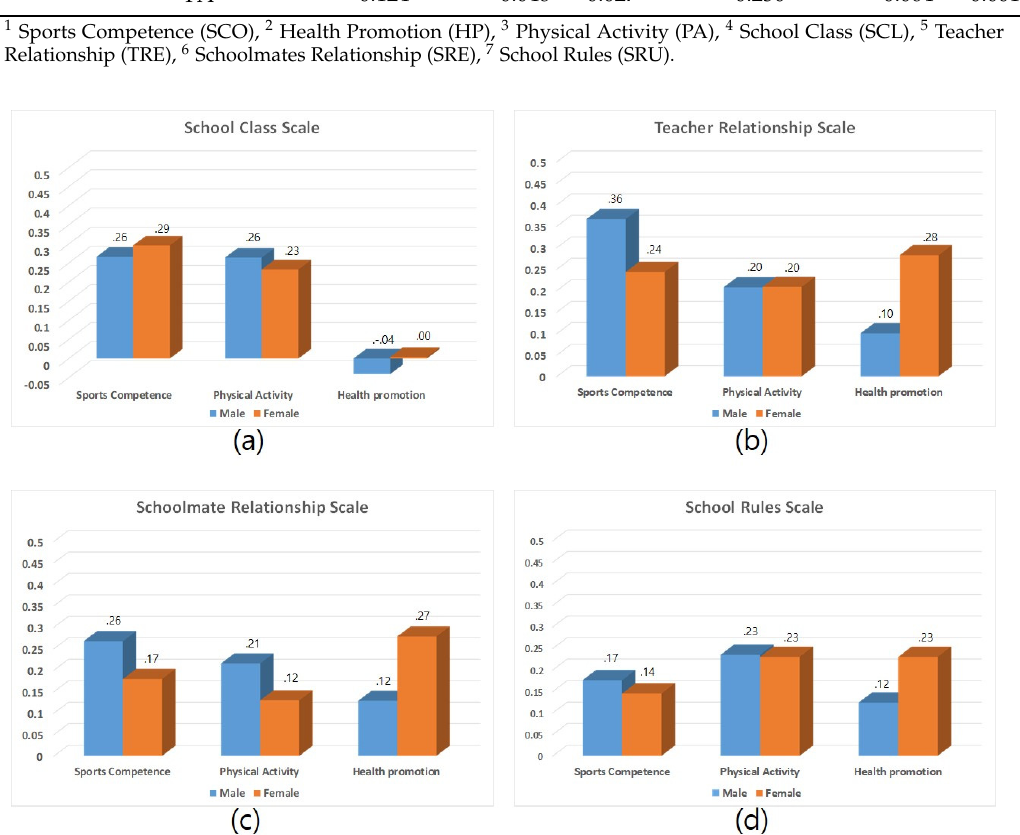
Table 7. Linear Regression of Physical Self-Concept and School Adjustment According to Award (n = 589). Dependent Variable